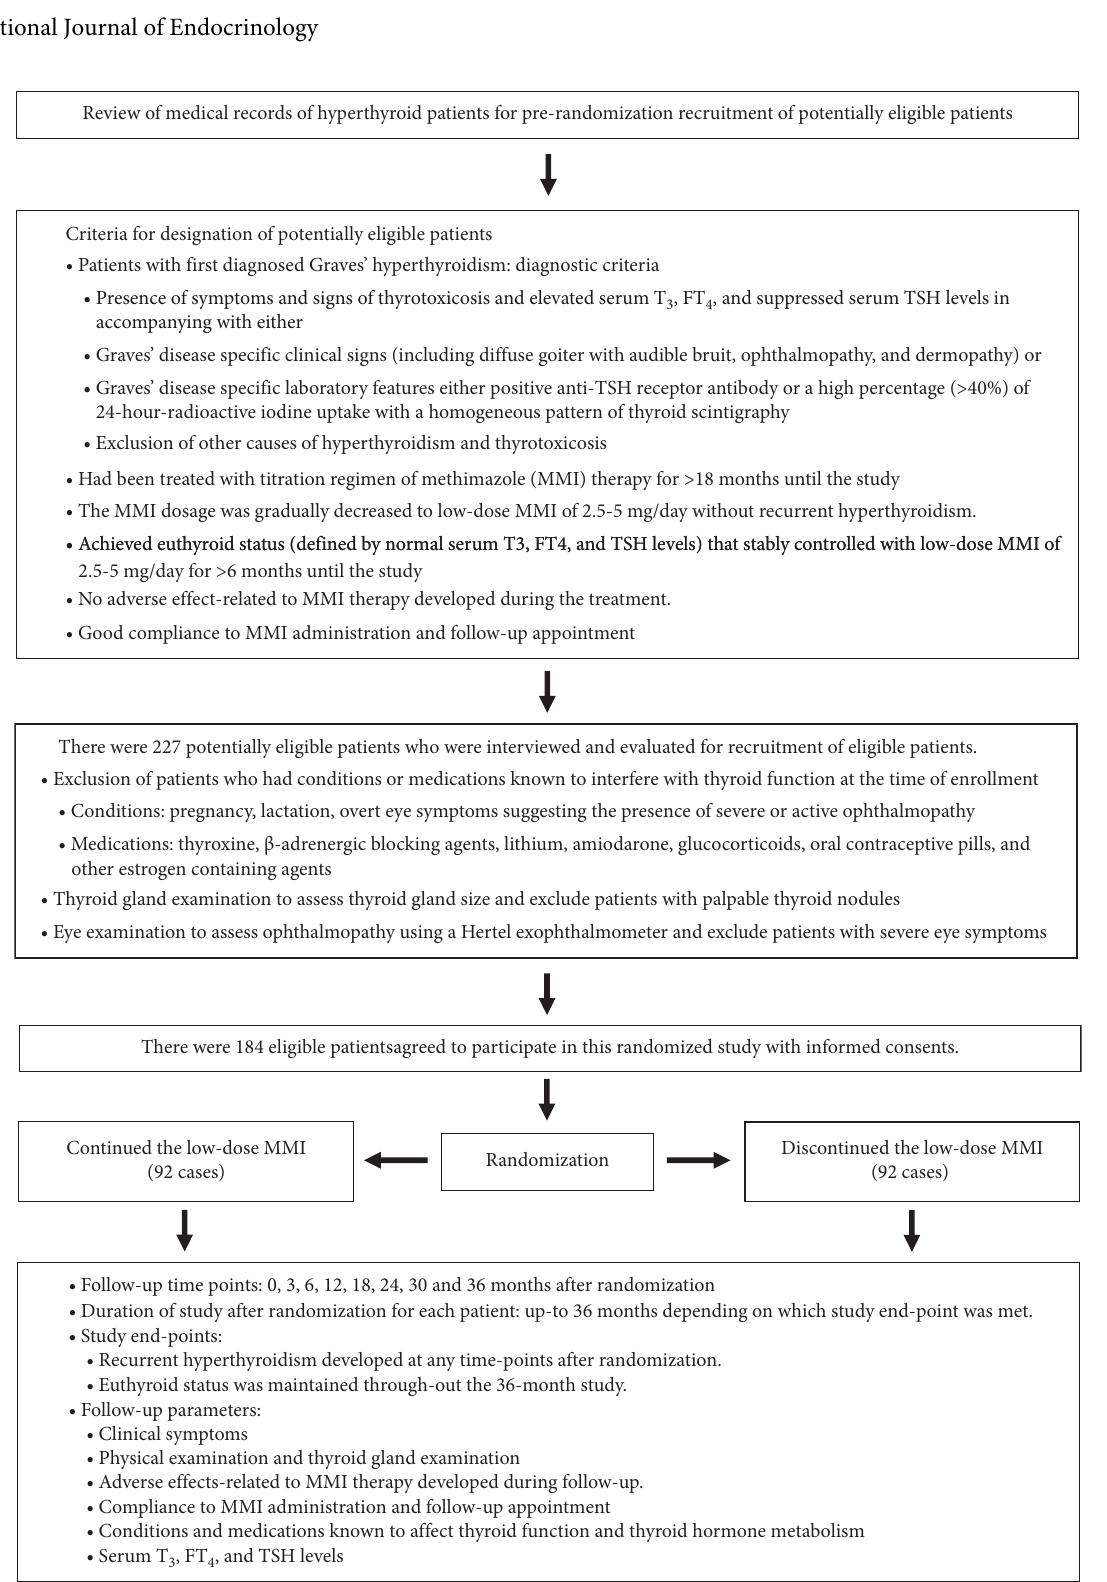
Figure 1: Prerandomization recruitment of eligible patients, randomization, and